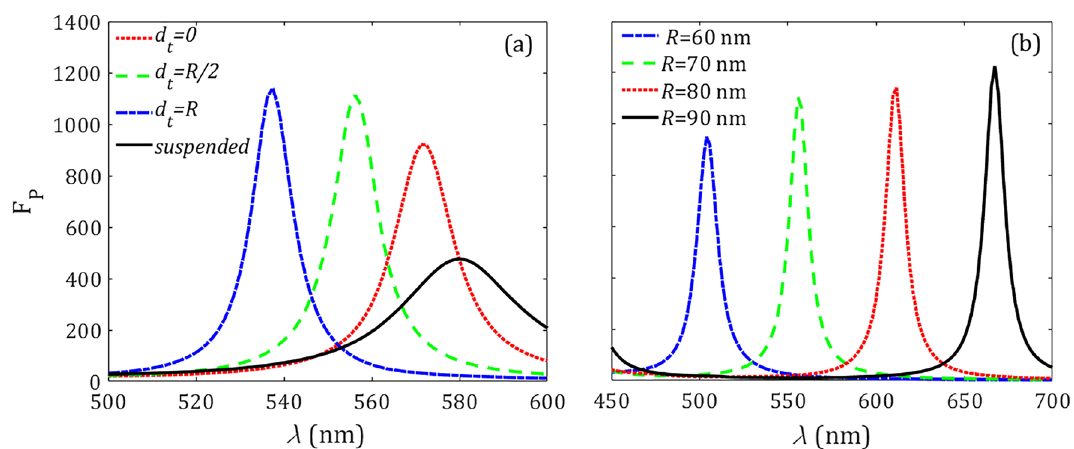
Figure 7. ( a ) Purcell factor of the structure shown in Fig. 6 for different d t , fixing the emitter location at d 10 nm from the resonator center, R 70 nm, and α 30 ◦ . For comparison, the PF of the dipole in the = = = absence of substrate with the same parameters has been included (solid curve). ( b ) Purcell factor for different R / 2 resonator radii while keeping d t =